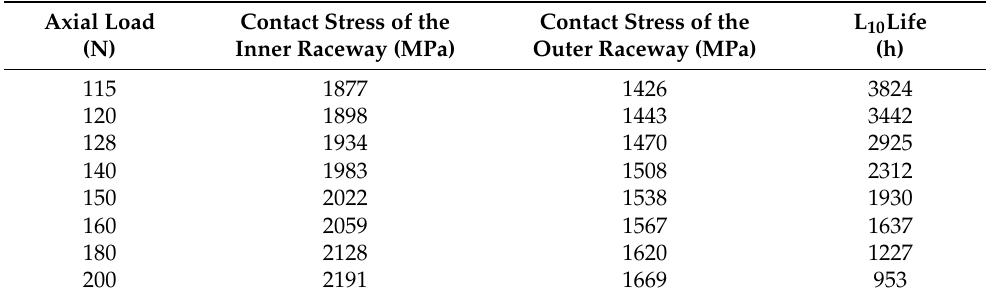
Table 4. Calculation results of the contact stress and L 10 life of the deep-groove bearing under different axial load.